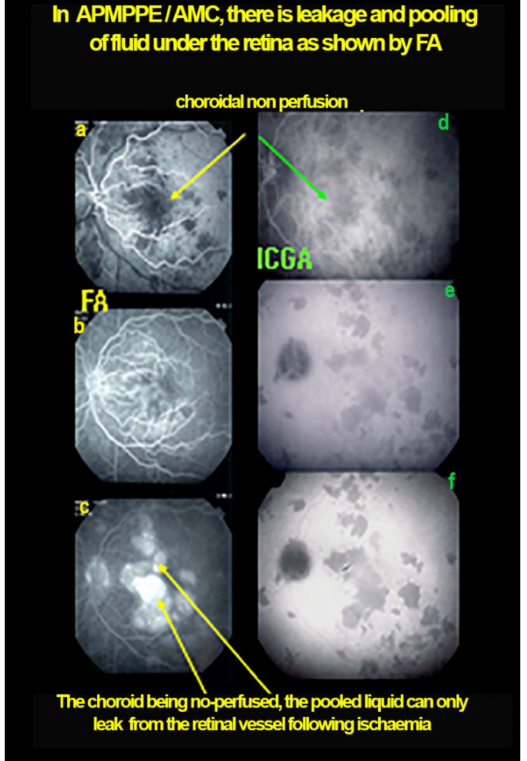
Figure 12. Case of APMPPE/AMIC: explanation of FA pooling (FA, left column, ICGA, right column) Choroidal (choriocapillaris) non-perfusion causes retinal ischaemia with retinal vessel increased permeability causing leakage and pooling under the retina. Early frames ( a , d ), mid-phase ( b , e ) and late phase ( c , f